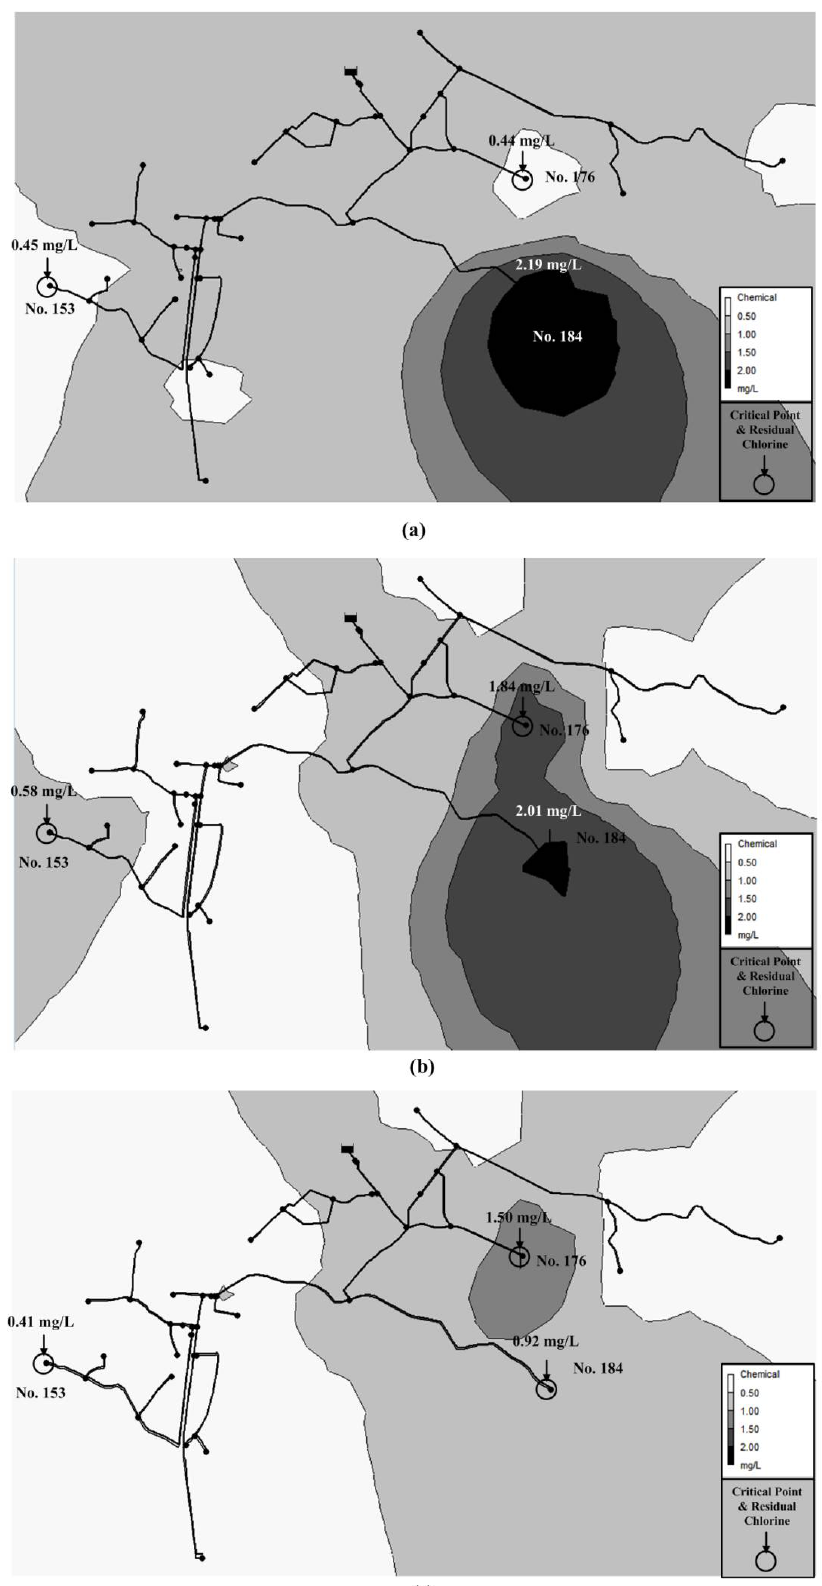
Figure 10. Locations of re-chlorination points for each scenario (network 2).